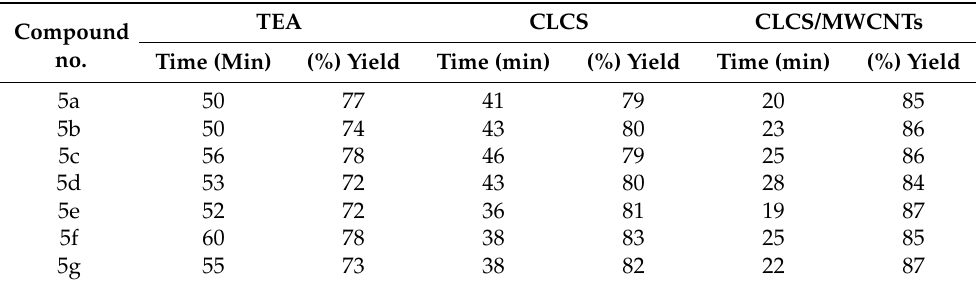
Table 2. Comparison of synthesis of bis-thiazoles 5a – g under ultrasound irradiation using a different basic catalyst on the time of reaction and the yield % of the products. Compound